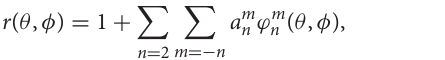
(cos θ sin φ , sin θ sin φ , cos φ ) is the vector on the unit